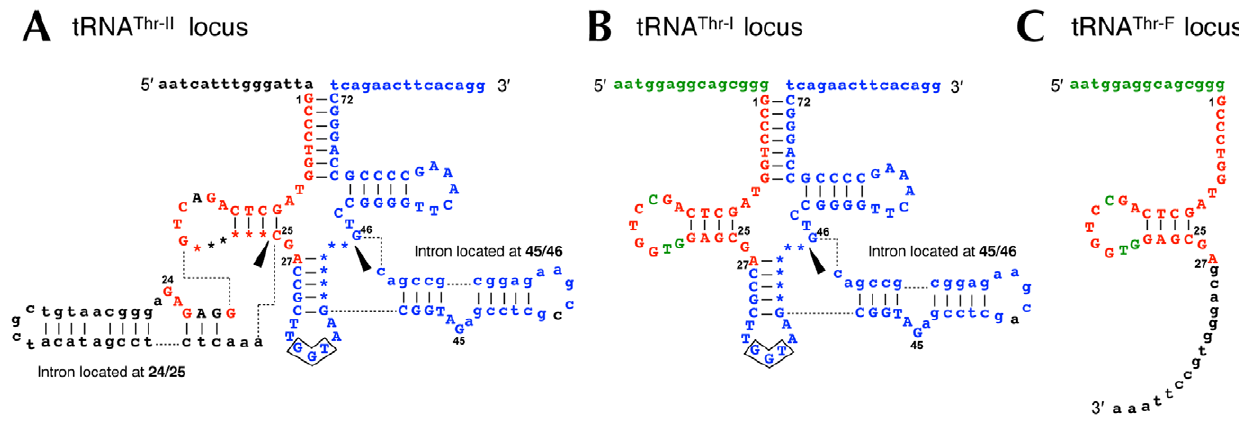
Figure 1. Sequences and secondary structures of the DNA regions encoding the tRNA Thr (GGU) genes and a tRNA Thr (GGU) fragment. (A) tRNA Thr (GGU) gene locus with two introns (tRNA Thr-II ) found in the composite genome of C. subterraneum . (B) tRNA Thr (GGU) gene locus with one intron (tRNA Thr-I ) found in clone JFF006_G04. (C) tRNA Thr (GGU) fragment (tRNA Thr-F ) found in the composite genome. Positions in the tRNA are numbered as described previously [2]. Nucleotides in the tRNA exon are shown in upper-case letters. Nucleotides conserved among A, B, and C, between A and B, and between B and C are shown as red, blue, and green, respectively. Black triangles indicate the locations of introns. The predicted anticodon is boxed. The 15-nt extensions at the 5 9 and 3 9 termini of the tRNA structures are defined randomly, and are not the actual leader or trailer sequences of potential pre-tRNAs.